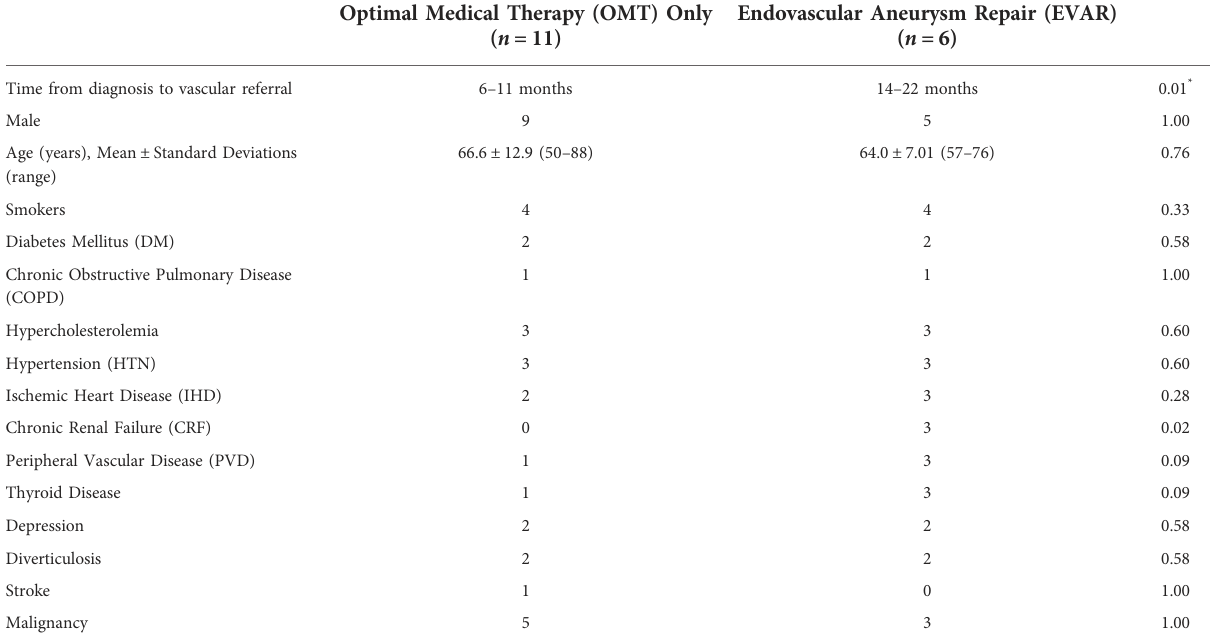
TABLE 1 Baseline demographics of the